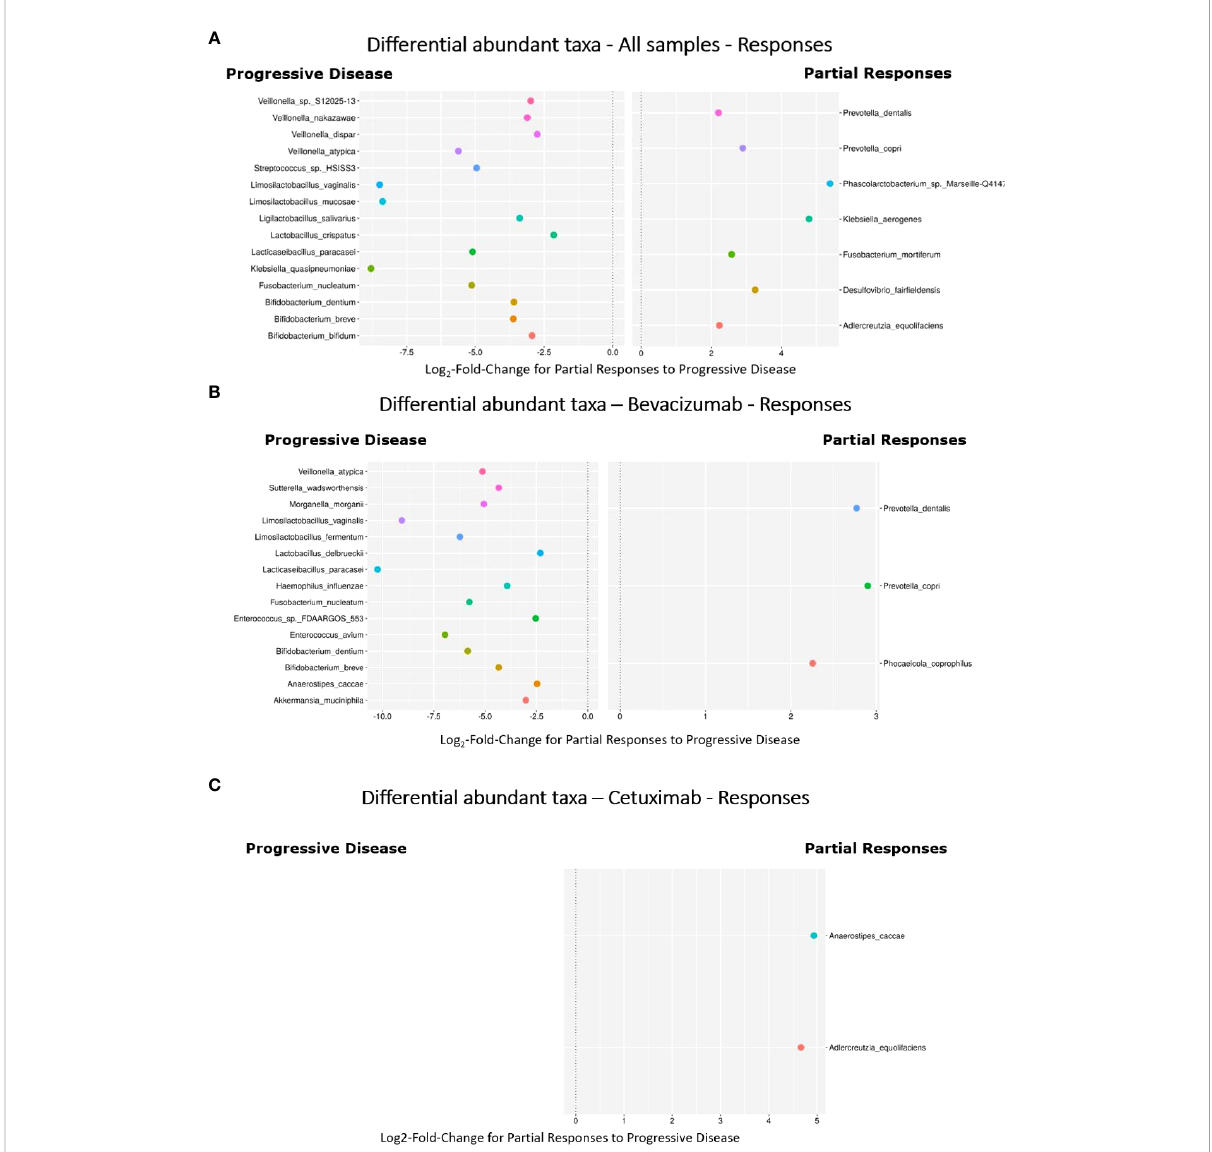
FIGURE 4 Results of the log 2 fold change in the disease progression and partial response groups and subgroups of bevacizumab and cetuximab. Each dot indicates a speci fi c bacteria species with a signi fi cant difference ( P < 0.05) indicated on the y -axis. Positive values on the x -axis indicate that the bacterial species was signi fi cantly more abundant in the PR than in the PD group and subgroups. Negative values indicate the opposite. The zero point indicates the equal fold of abundance in both the groups (2 0 ). Only log 2 fold change values >|2| are shown. (A) Bacterial expression was compared between the PD and PR groups. Fusobacterium nucleatum in the PD group was located at approximately the − 5 point (log 2 fold change = − 5.13, P adj = 3.37e-6), indicating that the expression of F. nucleatum was higher in the PD group than in the PR group by approximately 32 (2 5 ) times. Prevotella copri in the PR group was located at approximately 3 point (log 2 fold change = 2.90, P adj = 0.043), indicating that the expression of P. copri was higher in the PR group than in the PD group by approximately 8 (2 3 ) times. (B) In the bevacizumab-PD subgroup, Lacticaseibacillus paracasei exhibited the highest fold change in abundance by more than 1000 (2 10 ) times compared with the bevacizumab-PR subgroup (log 2 fold change = − 10.23, P adj = 8.28e-8). Other Lactobacillus species, including Limosilactobacillus vaginalis , Limosilactobacillus fermentum , and Lactobacillus delbrueckii , exhibited a higher fold change in abundance in the PD group than in the PR subgroup (log 2 fold change = − 9.06, P adj = 4.15e-10; log 2 fold change = − 6.22, P adj = 8.90e-6; and log 2 fold change = fi dobacterium dentium and Bi fi dobacterium breve presented a higher fold of abundance (log − 2.32, P adj = 6.22e-6, respectively). Bi 2 fold change = − 5.85, P adj = 8.90e-6 and log 2 fold change = − 4.34, P adj = 4.66e-5, respectively). F. nucleatum exhibited a higher fold change in abundance by approximately 64 (2 6 ) times (log 2 fold change = − 5.77, P adj = 2.84e-4). In the bevacizumab-PR subgroup, P. dentalis and P. copri revealed a higher fold change in abundance than did the bevacizumab-PD subgroup by approximately 8 (2 3 ) times (log 2 fold change = 2.77, P adj = 4.41e-3 and log 2 fold change = 2.90, P adj = 7.58e-3, respectively). (C) In the cetuximab-PD subgroup, no bacterial species presented a signi fi cantly different fold change in abundance. Anaerostipes caccae (log 2 fold change = 4.94; P adj = 2.47e-3) and Adlercrentzia equolifaciens (log 2 fold change = 4.70; P adj = 6.92e-3) revealed a higher fold change in abundance in the cetuximab-PR subgroup than in the cetuximab-PD